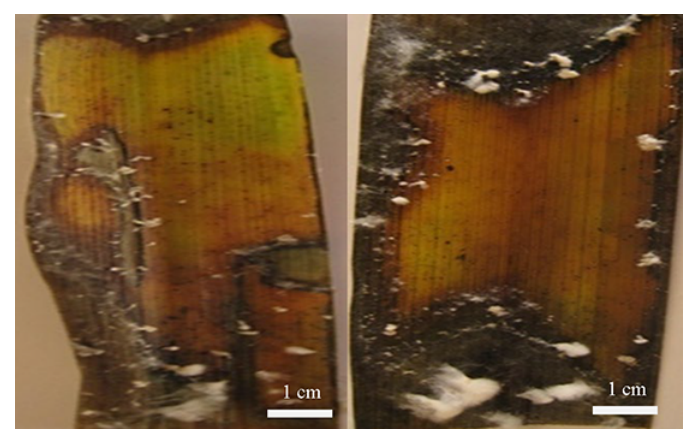
Figure 2 Symptoms developed on detached leaves of Typha latifolia artificially inoculated with a spore suspension of Bipolaris oryzae .